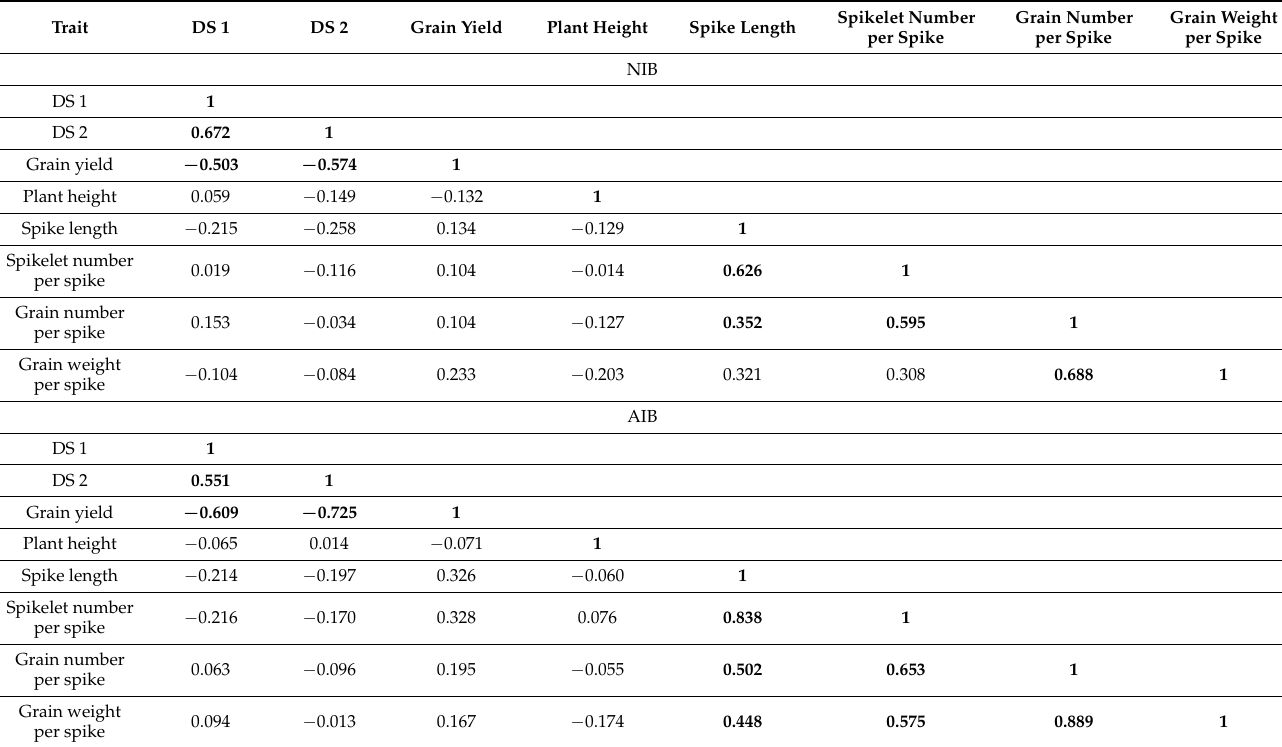
Table 3. Correlation coefficients between snow mold disease scores determined 1 (disease score 1) and 3 (disease score 2) weeks after the snow melt, grain yield, and parameters of yield structure for 58 rye accessions under a natural infection background (NIB) and an artificially-enriched infection background (AIB) in 2020–2021. Values in bold are statistically significant at p ≤ 0.001 ( t -test). DS—disease score.